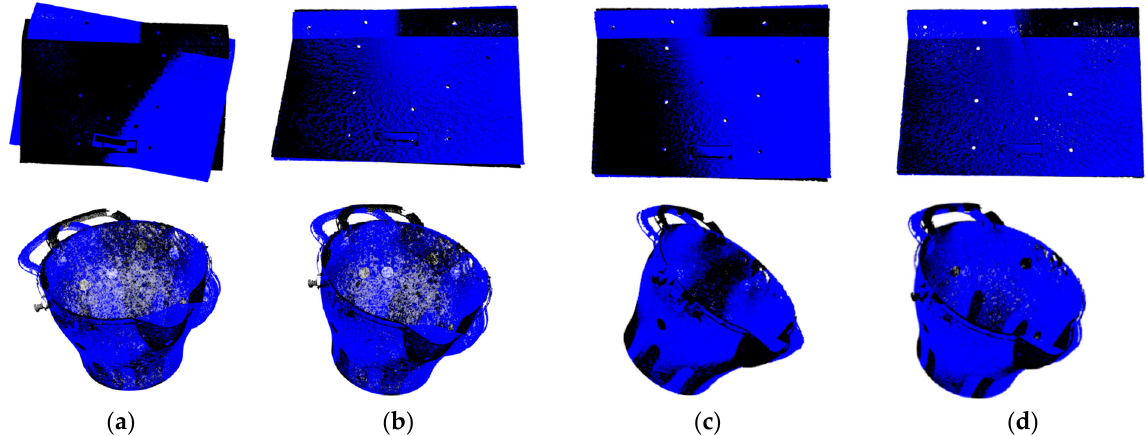
Figure 8. Results of workpiece point cloud registration. ( a ) Standard ICP algorithm; ( b ) Standard